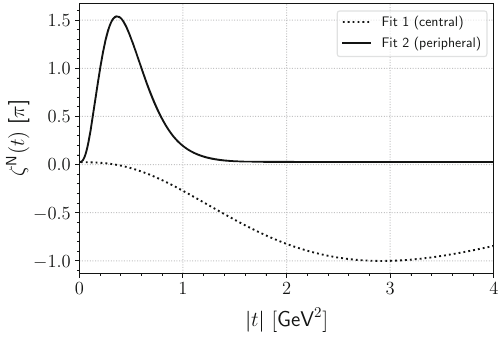
Fig. 3 t -dependence of elastic hadronic diffractive slopes B ( t )